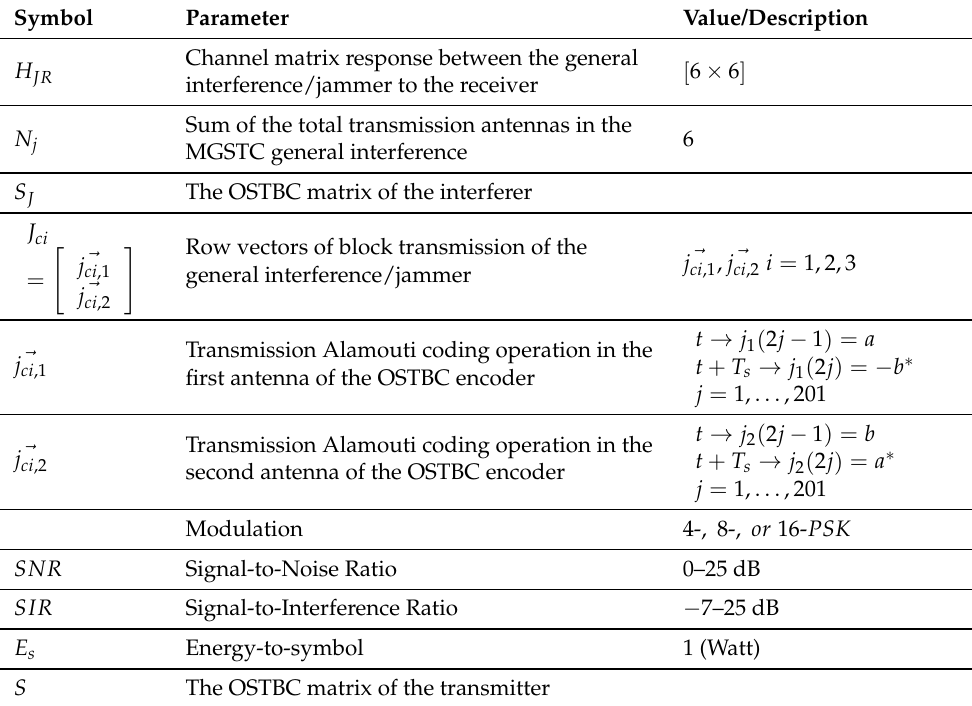
Table A2. Units and parameters used in the conducted